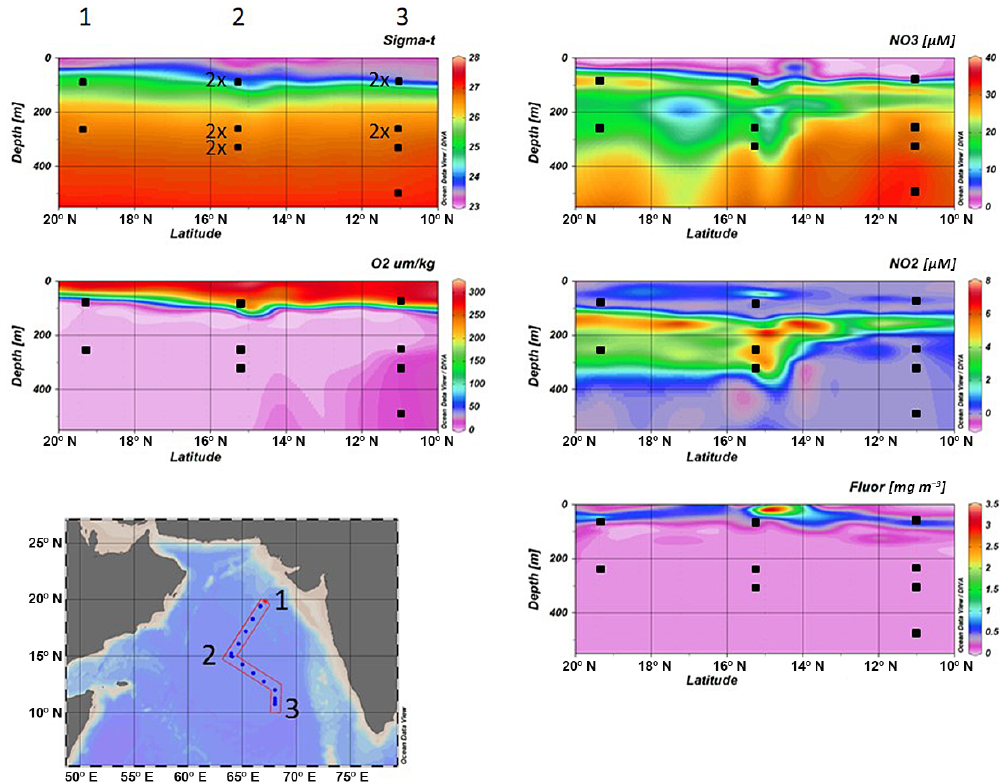
Figure 1. Spatial contours of water column parameters during the sediment trap deployments, clockwise from upper left: density, nitrate, nitrite, chlorophyll fluorescence, a map of the region including CTD stations (and with the trap deployment stations labeled 1–3), and oxygen. Squares in the upper left panel mark where sediment traps were deployed. A 2 × denotes two traps deployed at these depths. Nutrient data previously reported by Bulow et al.